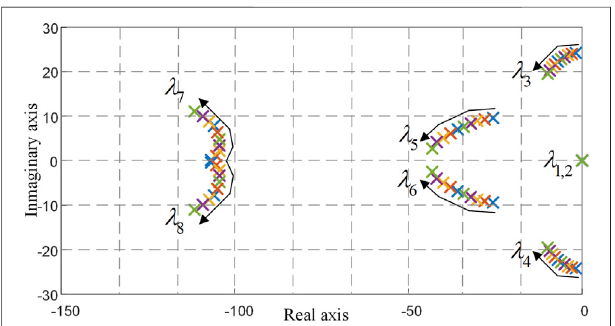
FIGURE 9 | Eigenvalues with control parameter change 0.3 ≤ k Hp ≤ 2.1.